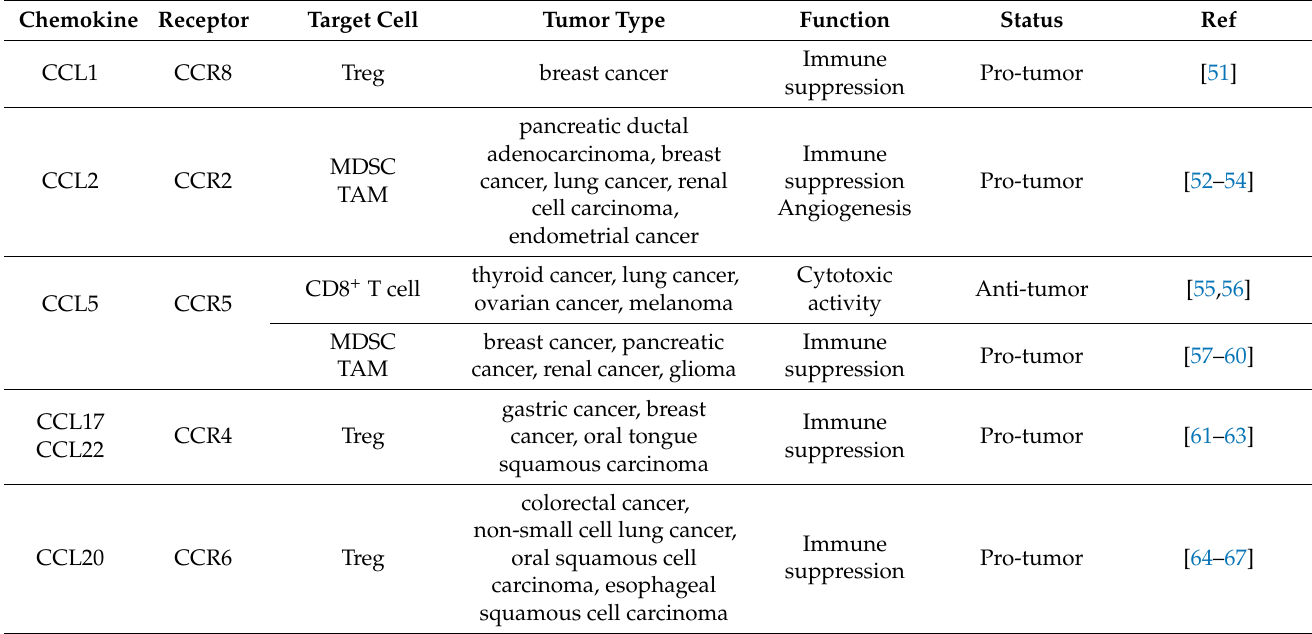
Table 1. Expression of chemokines and their roles in the tumor microenvironment. Chemokine